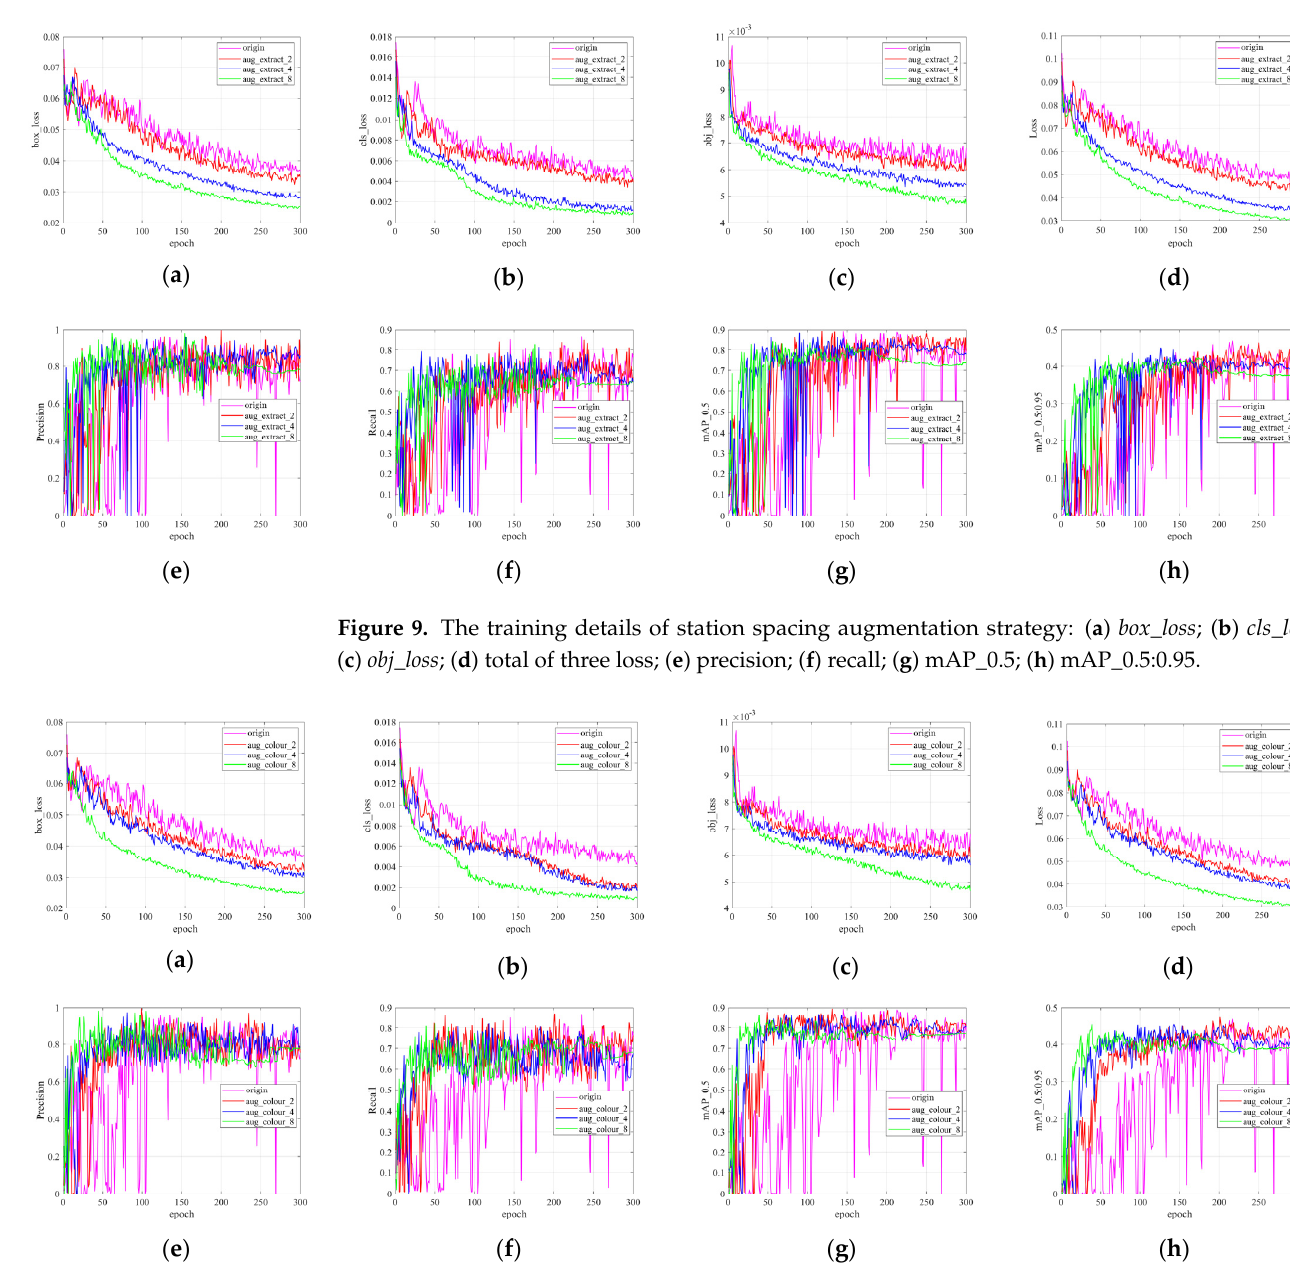
Figure 9. The training details of station spacing augmentation strategy: ( a ) box_loss ; ( b ) cls_loss ; ( c ) obj_loss ; ( d ) total of three loss; ( e ) precision; ( f ) recall; ( g ) mAP_0.5; ( h ) mAP_0.5:0.95.